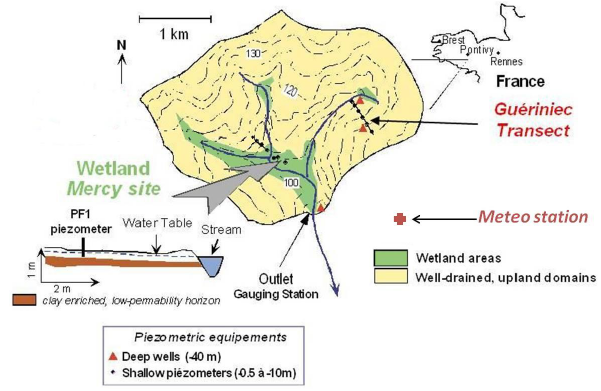
Fig. 1. Map of the Kervidy-Naizin experimental catchment and its location within Brittany,